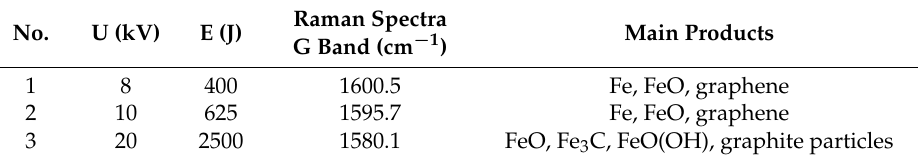
Table 1. Experimental conditions of pulsed iron wire discharge and characterization of recovered samples 1 .